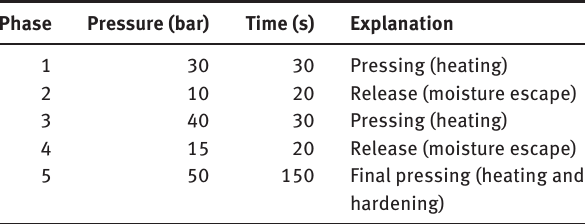
Table 1 Hot press program applied for removing moisture from particleboards.